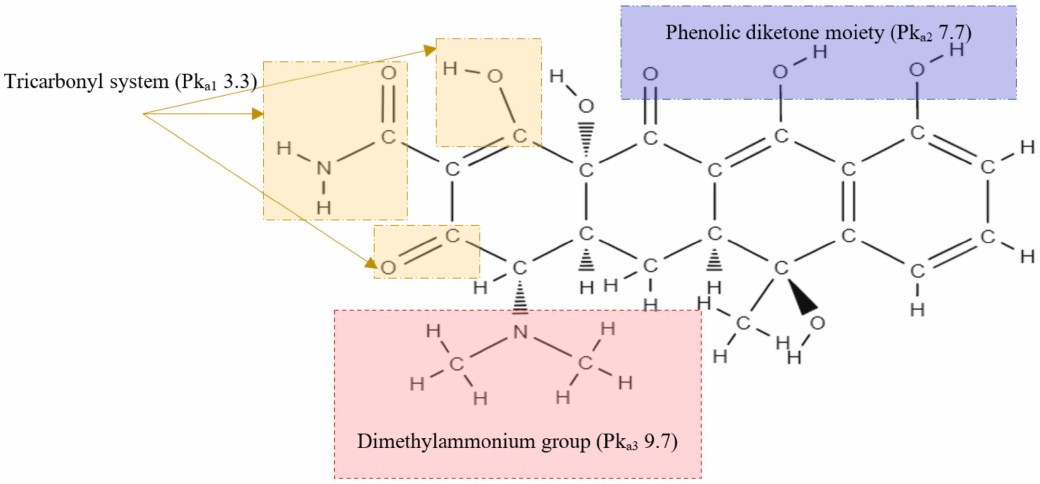
Figure 3. Planer view for the molecular structure of